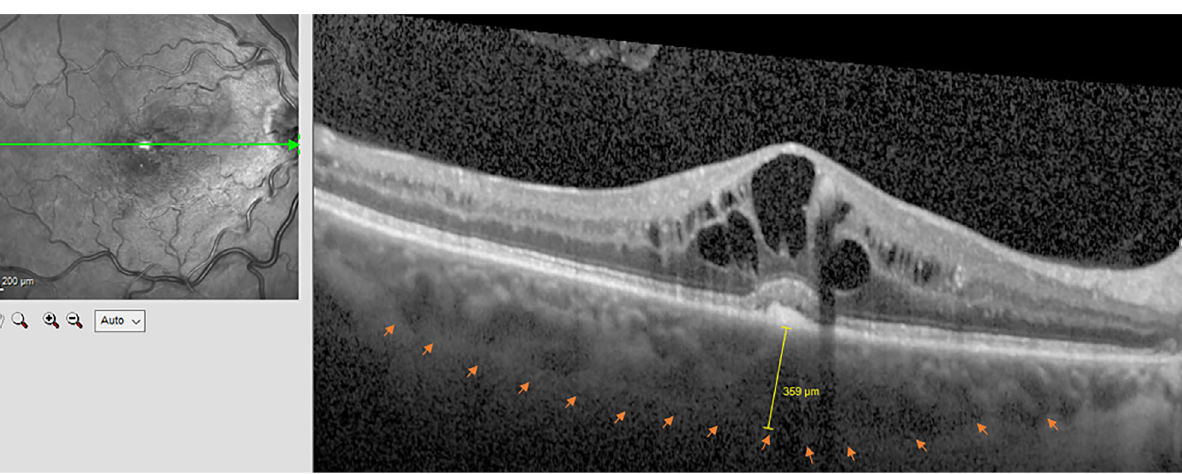
Figure 1. Measurement of subfoveal choroidal thickness (SFCT) using enhanced depth imaging optical coherence tomography (EDI-OCT) in a male patient of our study with central retinal vein occlusion. The inner surface of the sclera is indicated with the arrows. SFCT was 359